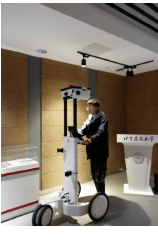
Figure 2. Scanning